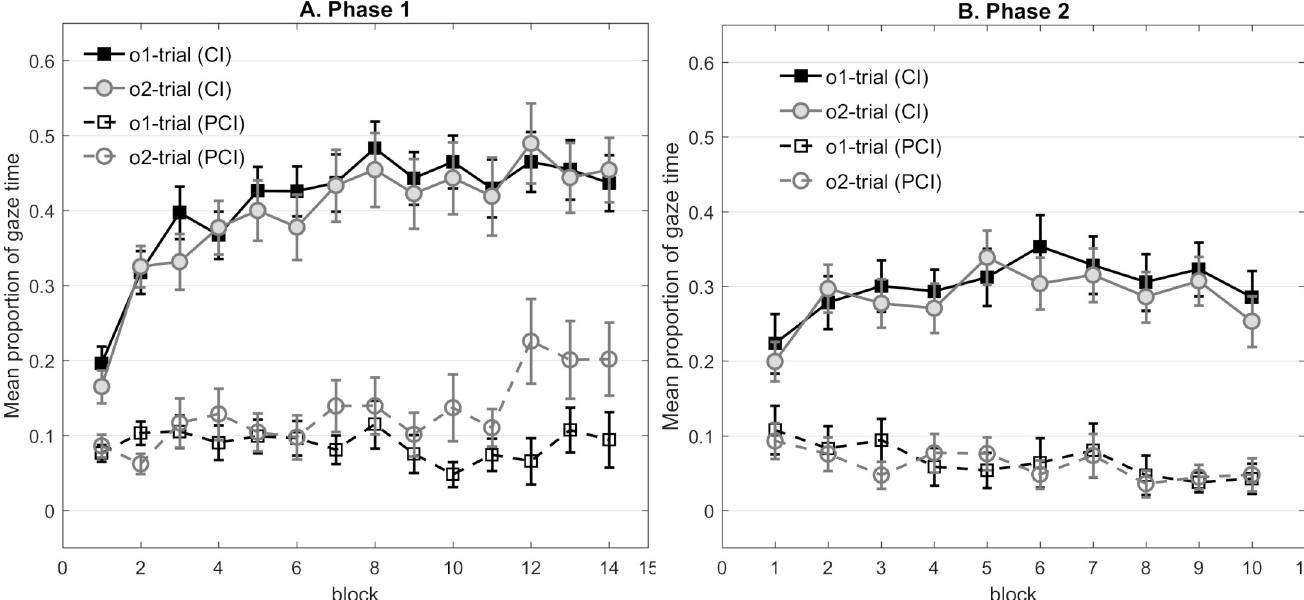
Fig 8. Panel A and B represent the mean proportion of gaze time in Experiment 6 that participants looked at the correct outcome’s cave during the cue (CI) and the pre-cue interval (PCI) respectively in each phase. (A) Mean gaze time across the 14 blocks in Phase 1. (B) Mean gaze time across the ten blocks in Phase 2. Note that i) gaze behavior on the trials without signaling ( Ø ! o2) in Phase 1 was not presented in the figure, and ii) gaze time in Phase 2 was averaged based on the predictability of each trial’s outcome in Phase 1.